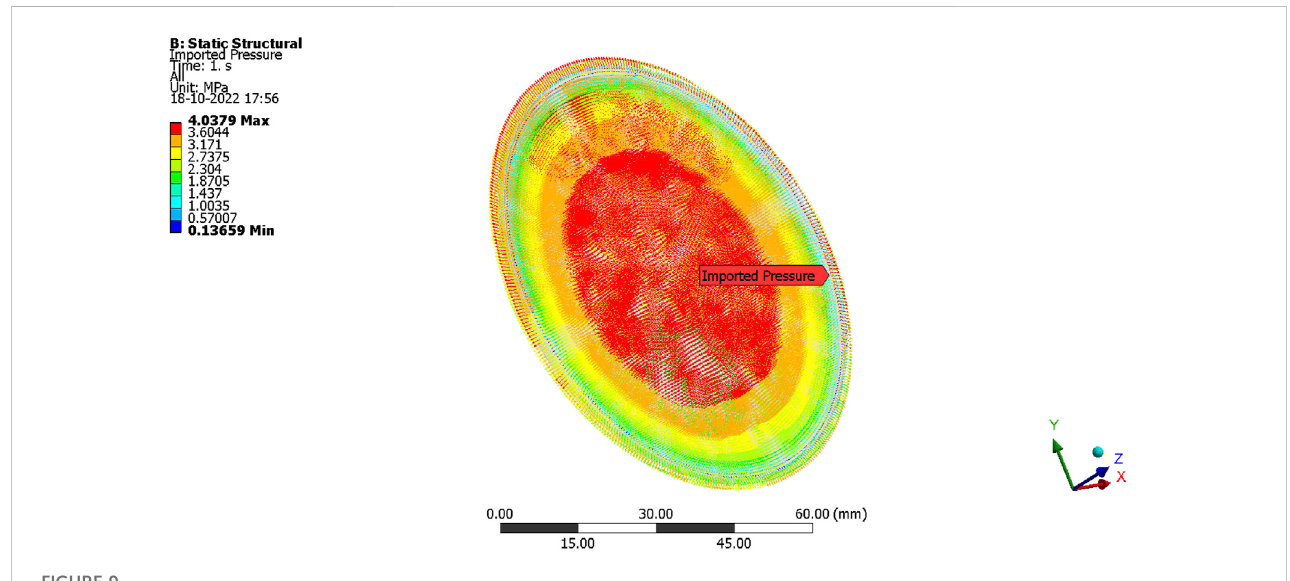
Imported pressure on the computational test specimen.